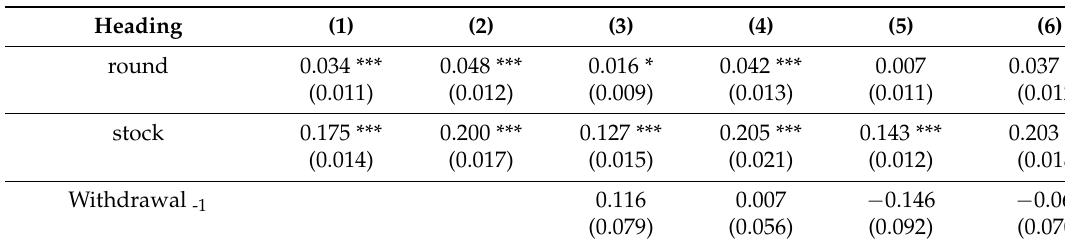
S2. Information Screen, Figure S3. Decision Screen, Figure S4. Feedback Screen.